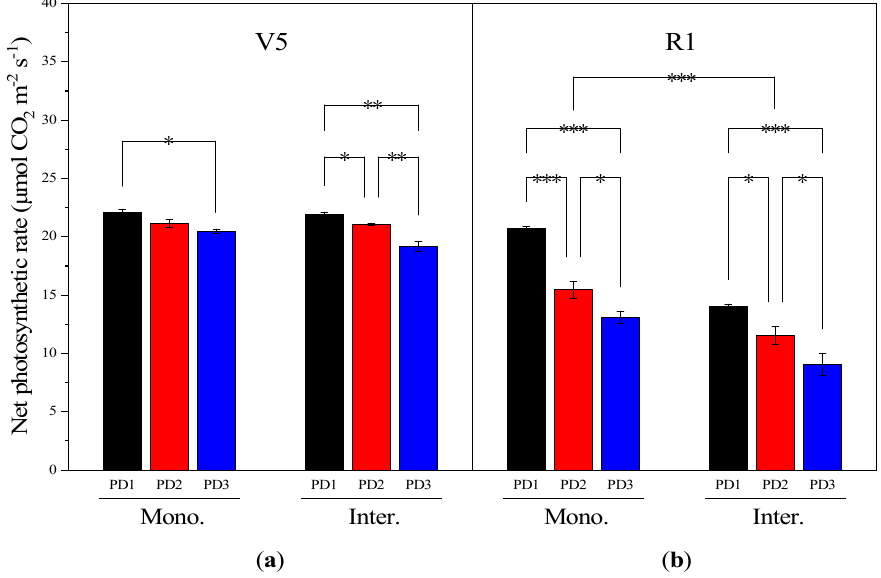
Figure 4. Effects of multiple planting densities (PD1 = 17, PD2 = 20, and PD3 = 25 plants m − 2 ) on the net photosynthetic rate of soybean leaves at V5 and R1 growth stages under both monocropping and strip intercropping system ( a ) and ( b ). All the values are means (±SE) standard error of three replications. Significance difference among the different treatments was displayed by *, **, and *** at probability level p ≤ 0.05, p ≤ 0.01, and p ≤ 0.001, respectively.